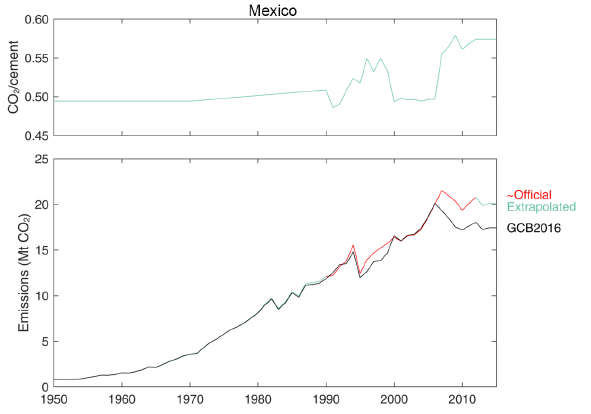
Figure C28. Clinker and cement production in Moldova (Ministry of Environment, 2013).